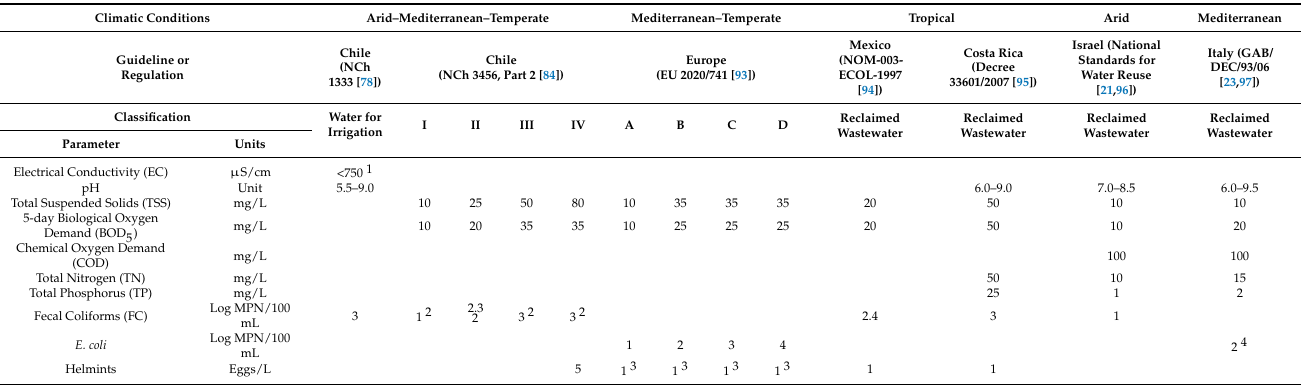
Table 5. Comparison of some water quality parameters relevant to the reclamation of wastewater including parameters for Chile, two Latin-America countries and countries with arid and Mediter- rannean